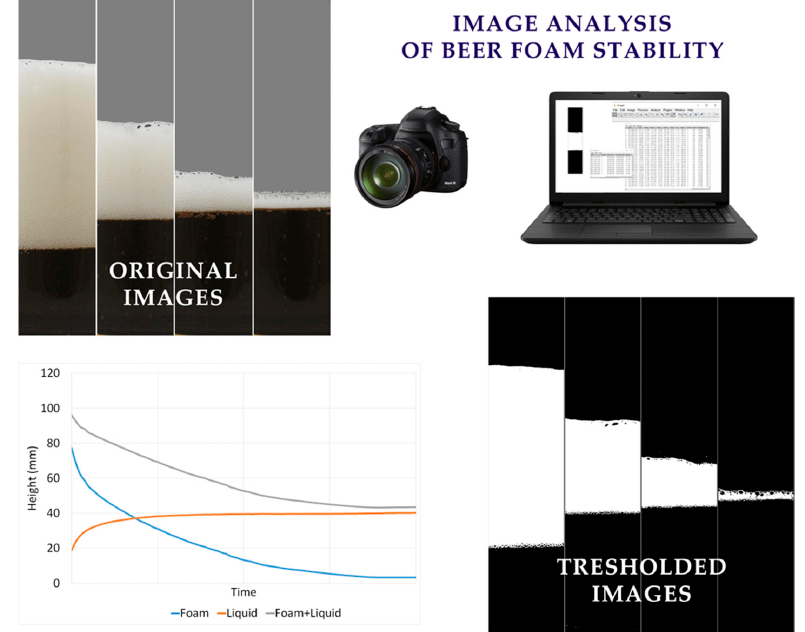
Figure 13. Image analysis of beer foam stability (original images and images with applied threshold segmentation; and graphical parameters presentation of the beer foam stability).